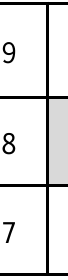
Figure 4. A 3 × 3 sized block.